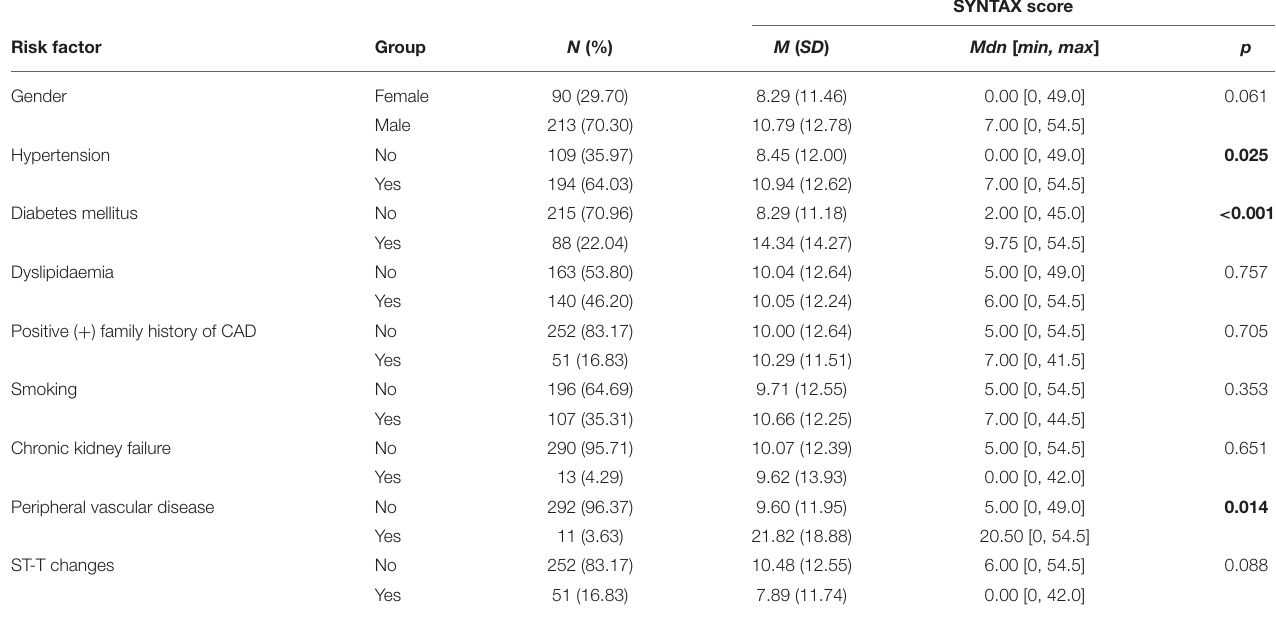
TABLE 3 | Descriptive and exploratory analyses for categorical risk factors and SYNTAX